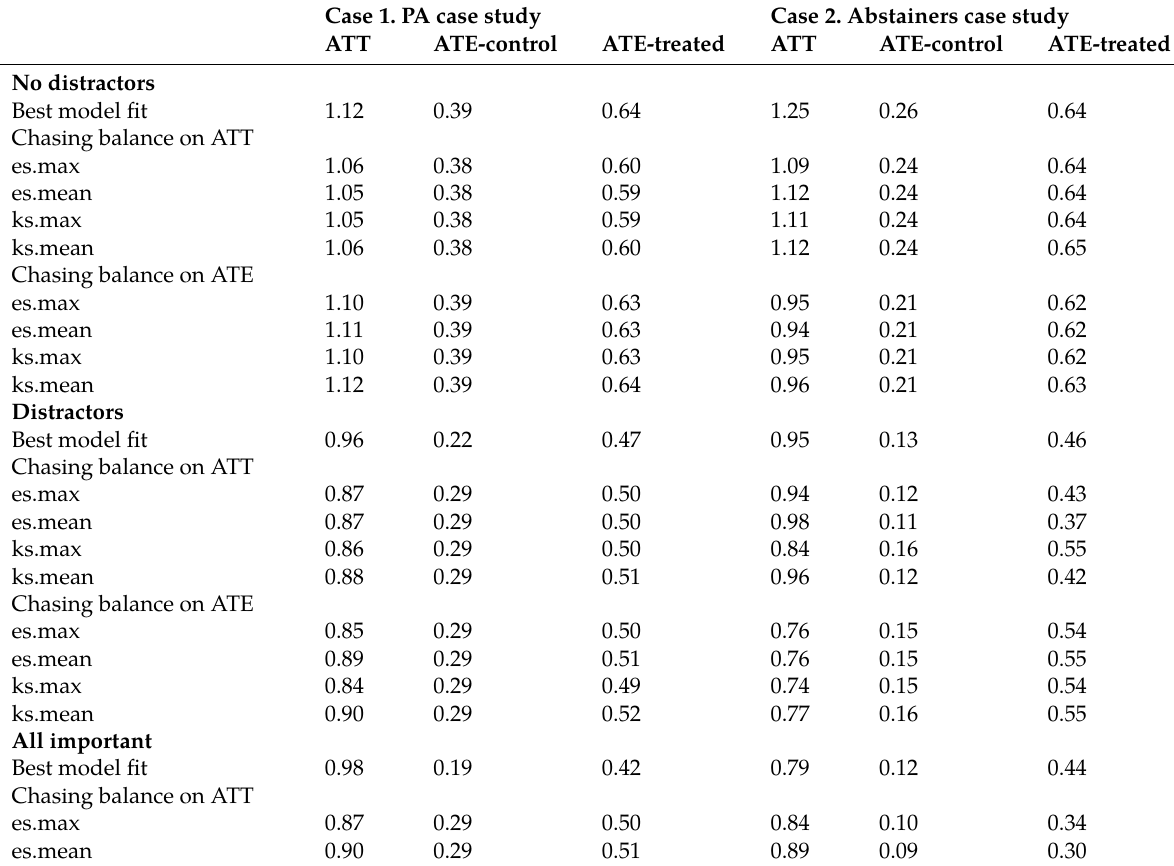
Table 7: The average coefficient of variation (CV) of the weights for all cases and